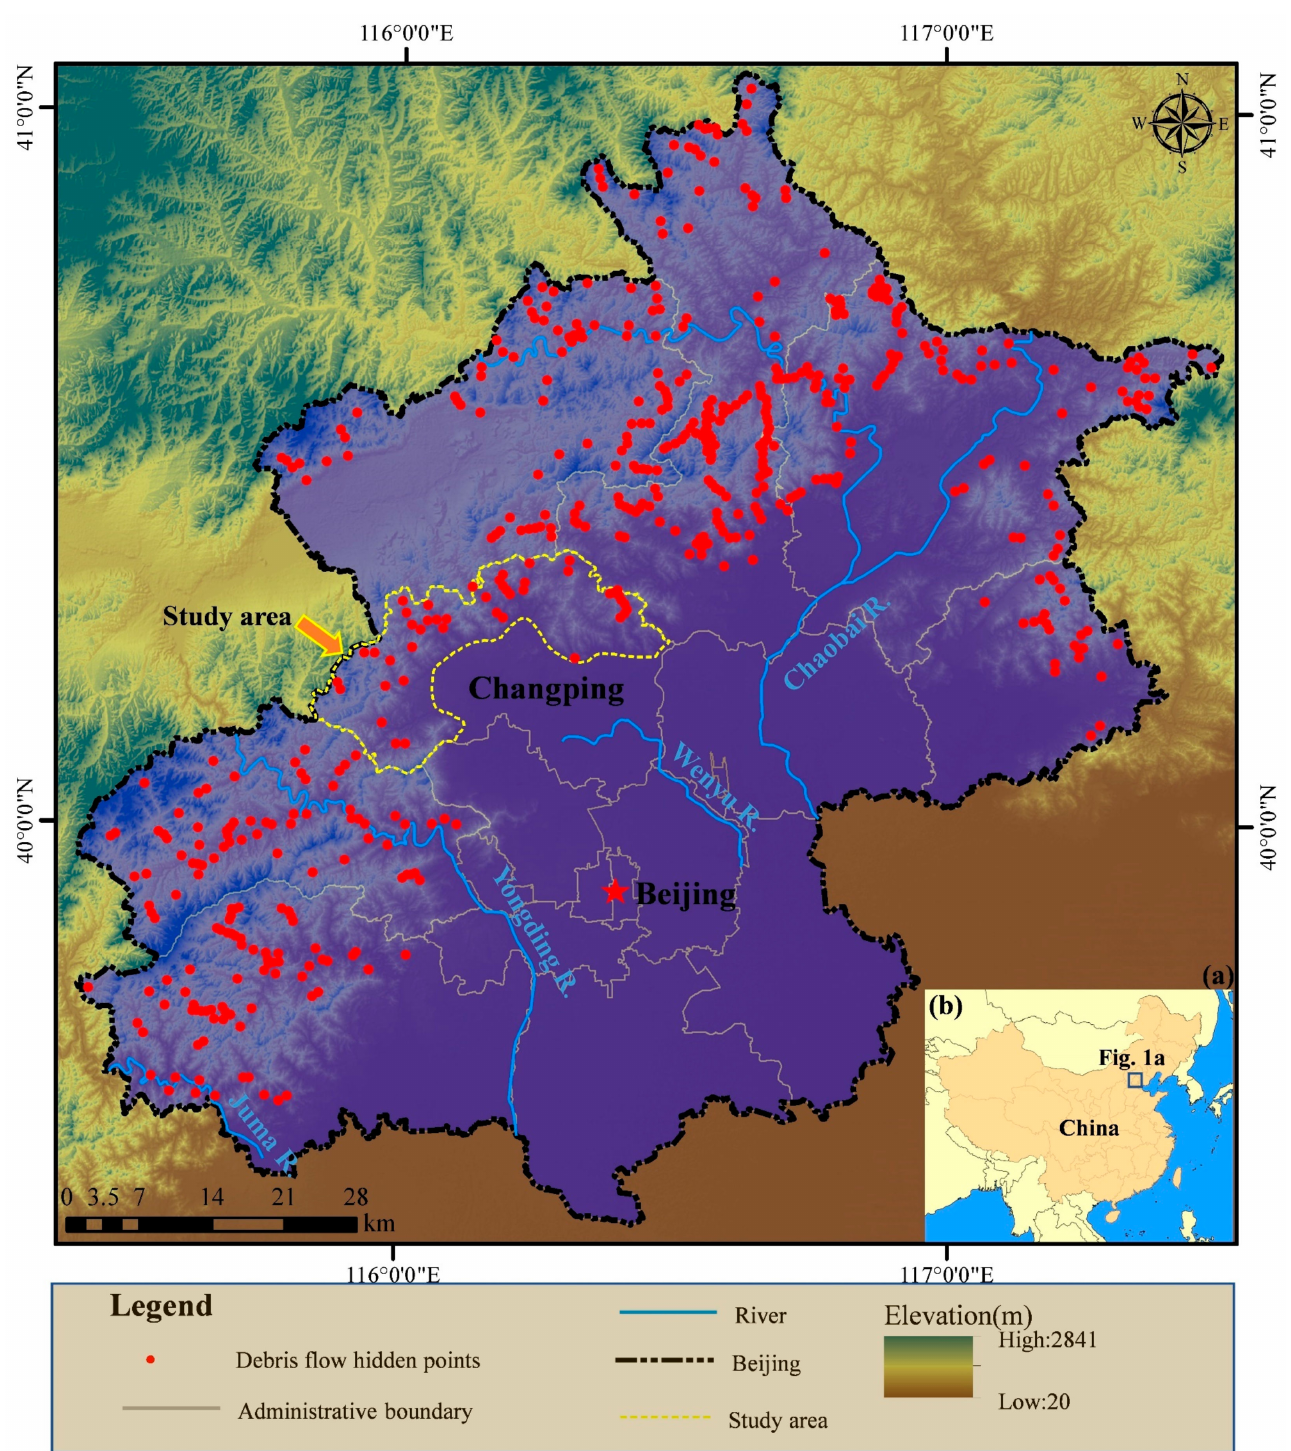
Figure 1. Debris flow distribution in Beijing and geographical location of study area. ( a ) The location of the research area in the whole of Beijing; ( b ) The location of the research area in the whole of